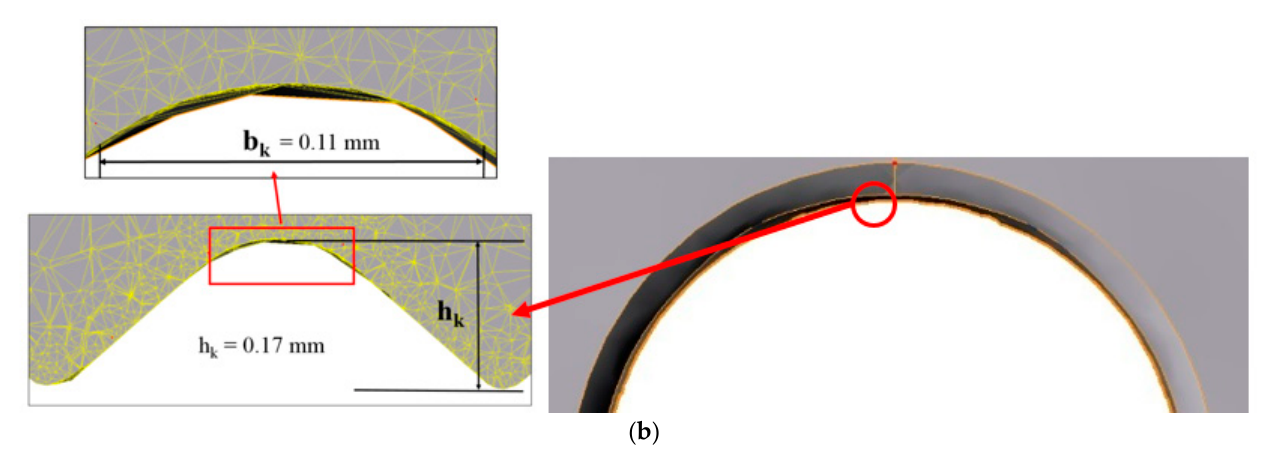
Figure 10. The contrast of experimental and numerical jointing process of the hub shape (version 3, COF 0.61): ( a ) optical photo of an experimental workpiece and ( b ) schematic simulation of workpiece.